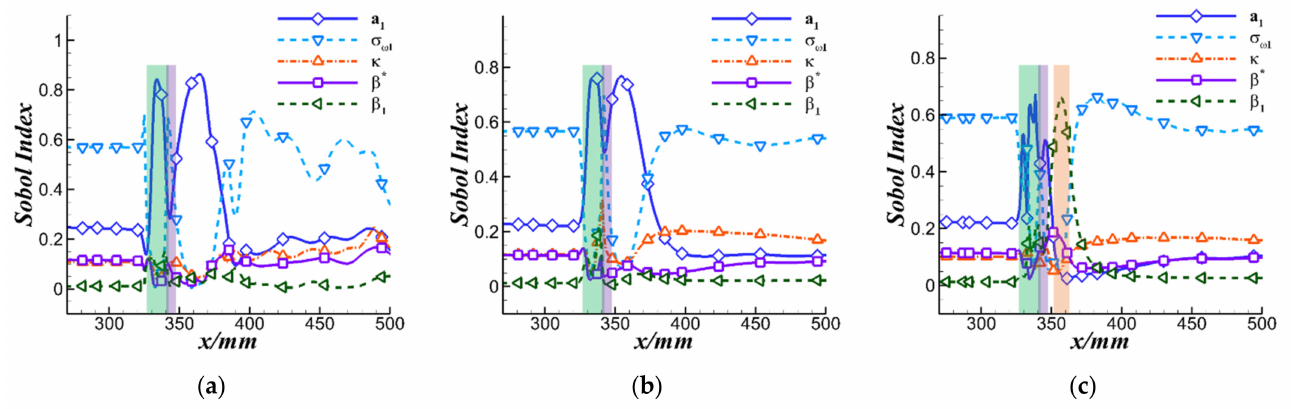
Figure 11. Distributions of the Sobol indices of model’s parameters for the wall properties in θ = 10 ◦ case. ( a ) Wall pressure; ( b ) skin friction; ( c ) wall heat